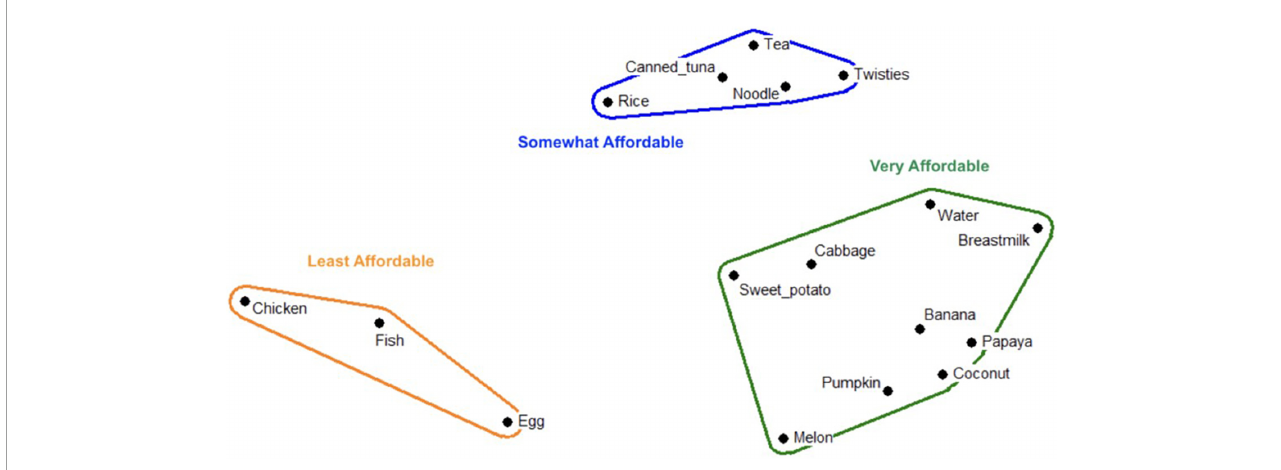
FIGURE2 Multi-dimensional scaling map depicting affordability of child foods in Kola’a (urban site); Stress: 0.093; Eigen value: 8.427; Eigen ratio: